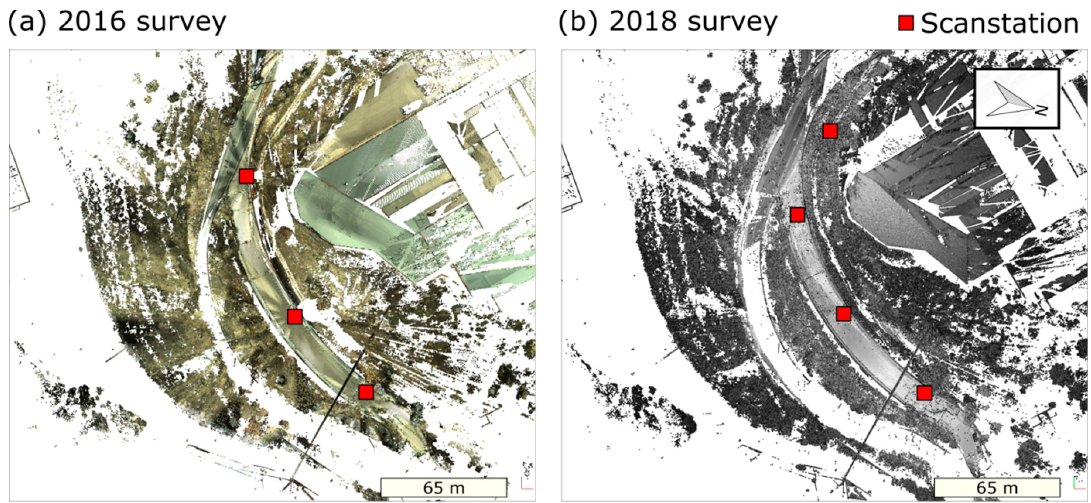
Figure 2. Top view of the two three ‐ dimensional (3D) point clouds acquired on ( a ) 6th May 2016 and ( b ) 27th April 2018.